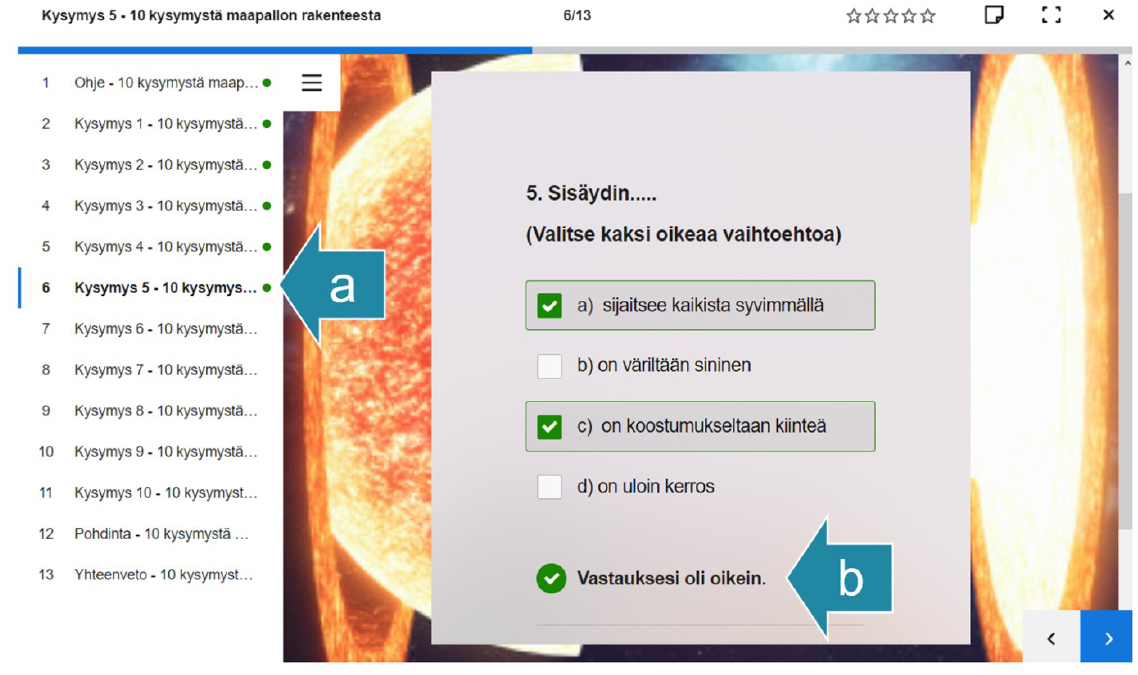
Preview of a task page in a content chapter, including: (a) progress marks indicating completed pages of a chapter and (b) feedback on the